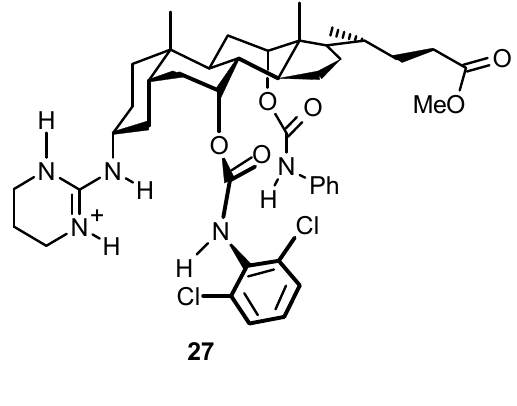
Figure 16. A steroidal guanidinium receptor [111].